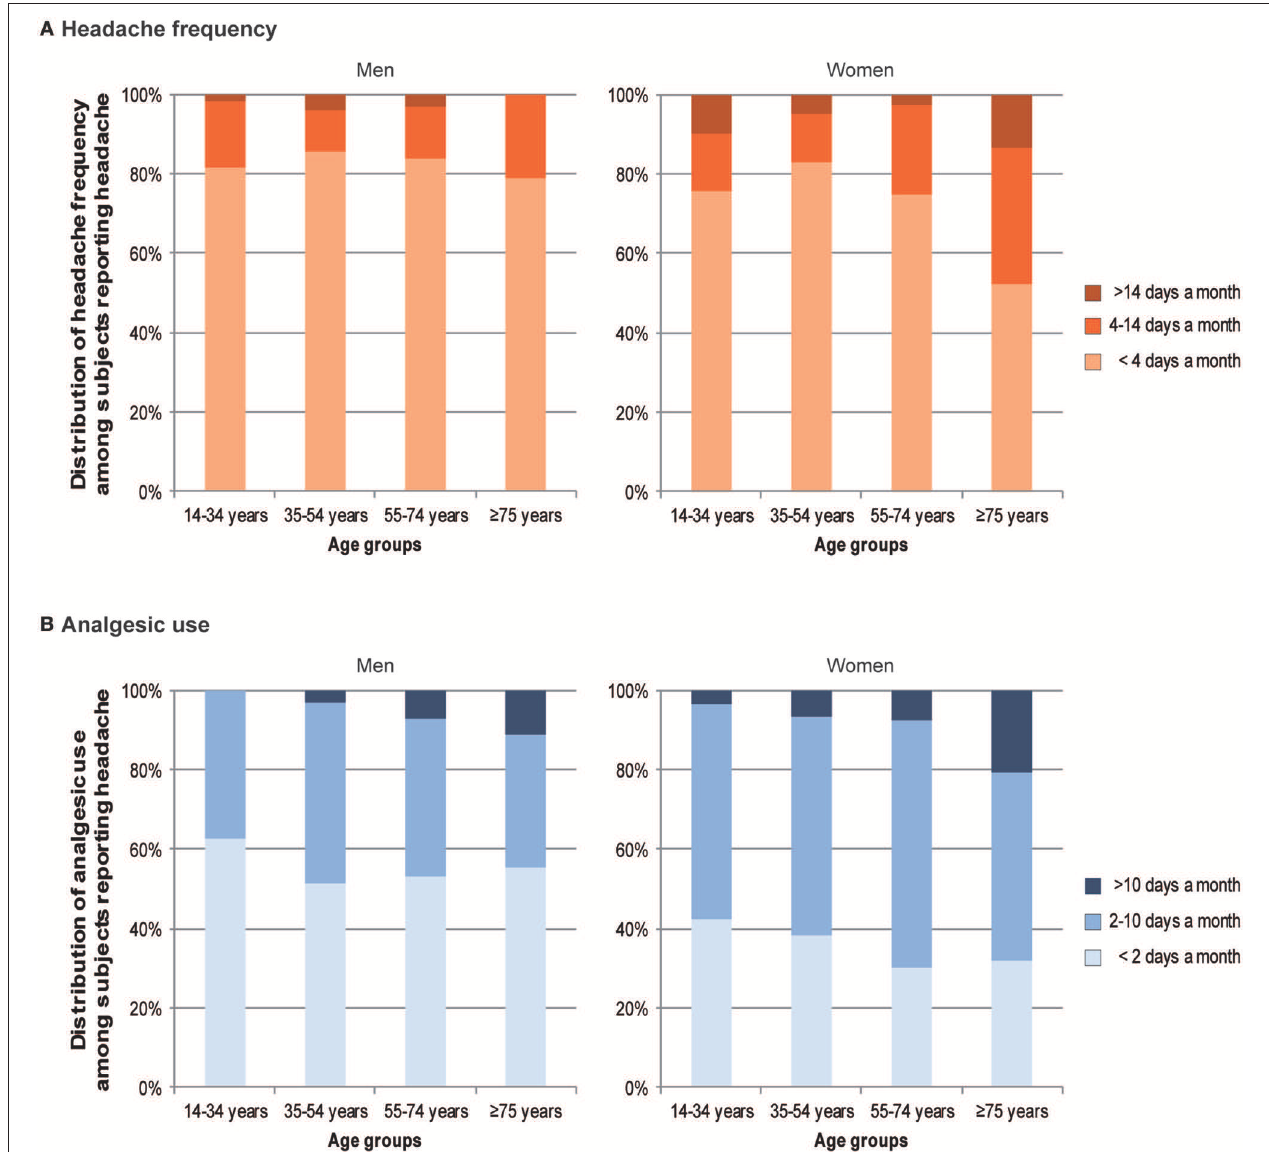
FIGURE 2 | Headache frequency (A) and analgesic use (B) depending on age